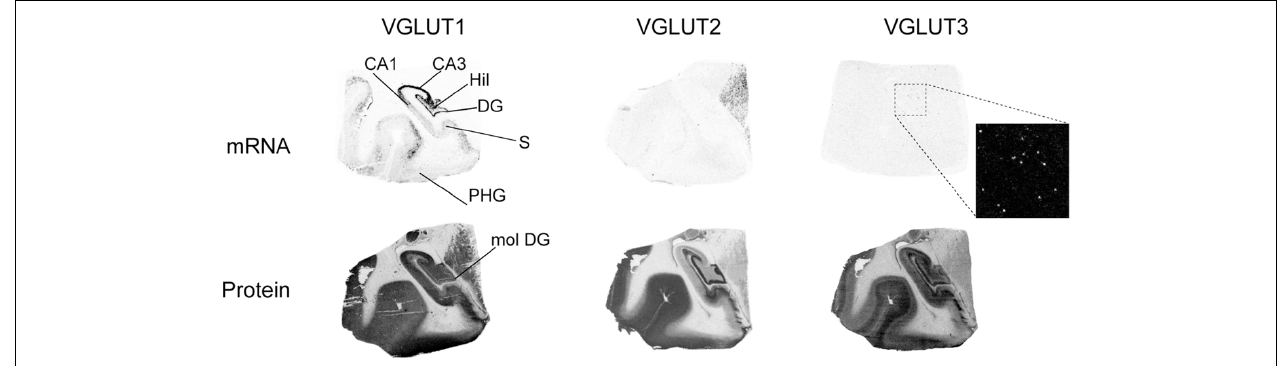
FIGURE 3 | Distribution of VGLUT1-3 mRNA and protein in the hippocampal formation. Boxed regions are enlarged and shown in negative. Abbreviations: CA1–3, fields of the pyramidal layer of the